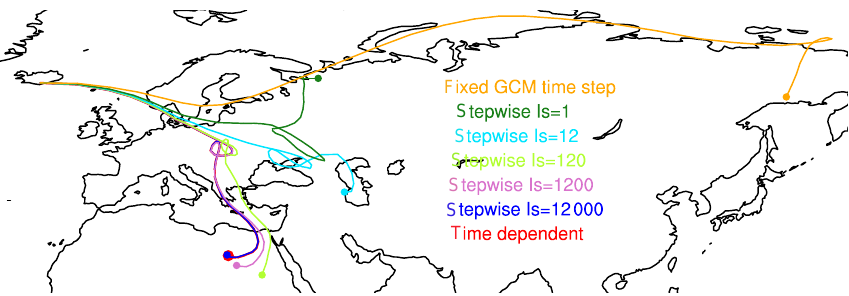
Figure 7. Example of atmospheric trajectory paths starting form the Eyjafjallajökull volcano during its eruption calculated with different trajectory schemes and number of intermediate time steps. The same colour coding of the trajectories as in Fig. 6 is used. Note that the red time-dependent and the blue stepwise schemes with I S = 12000 trajectories are nearly identical.